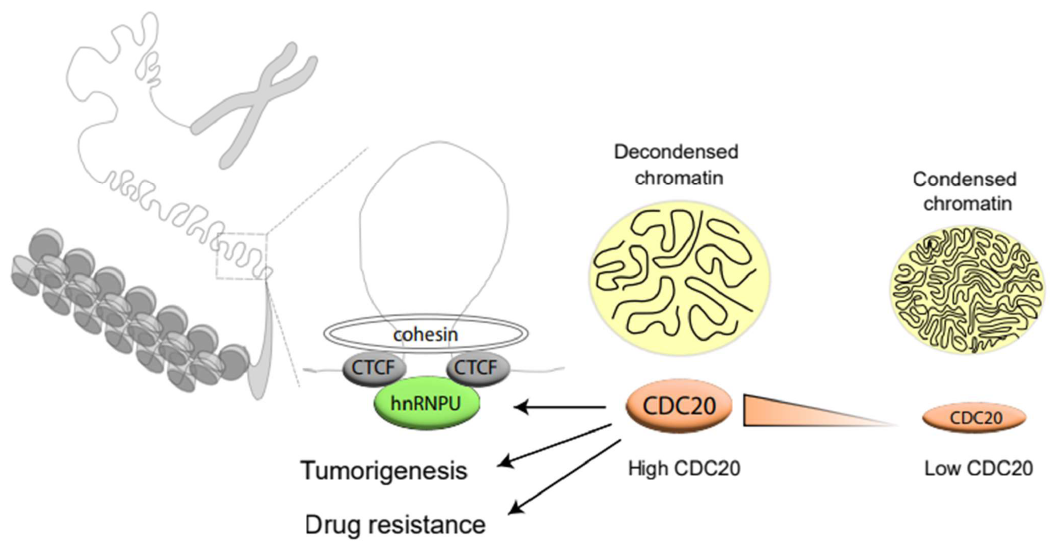
Figure 7. Aberrant CDC20–hnRNPU axis impairs the chromatin organization and causes drug resistance. Schematic diagram underlying the mechanism described in our study.